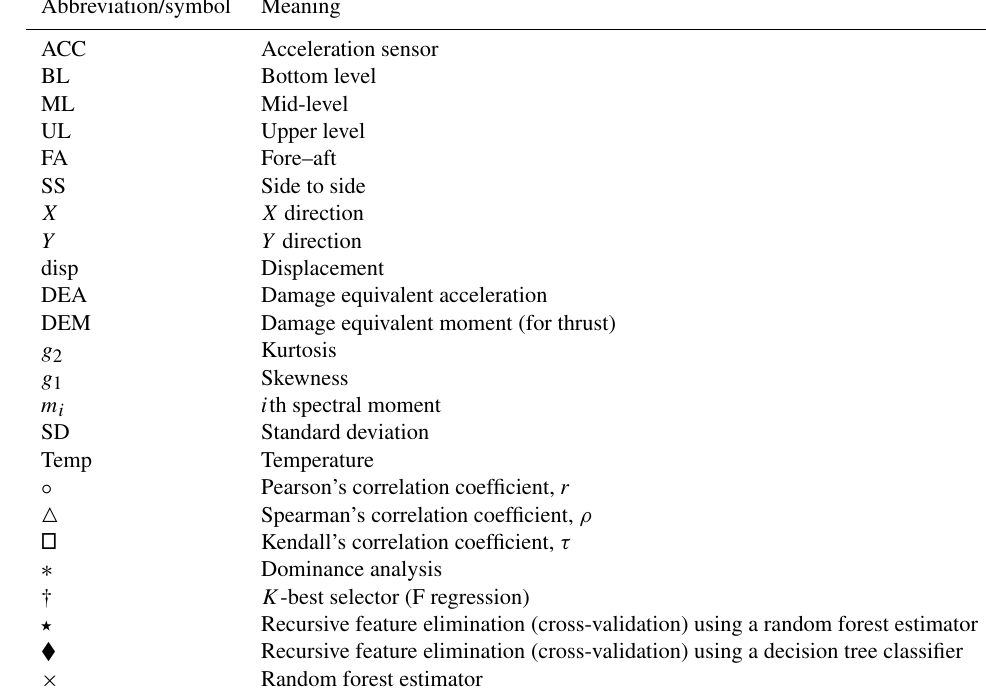
Table B1. Variable abbreviation